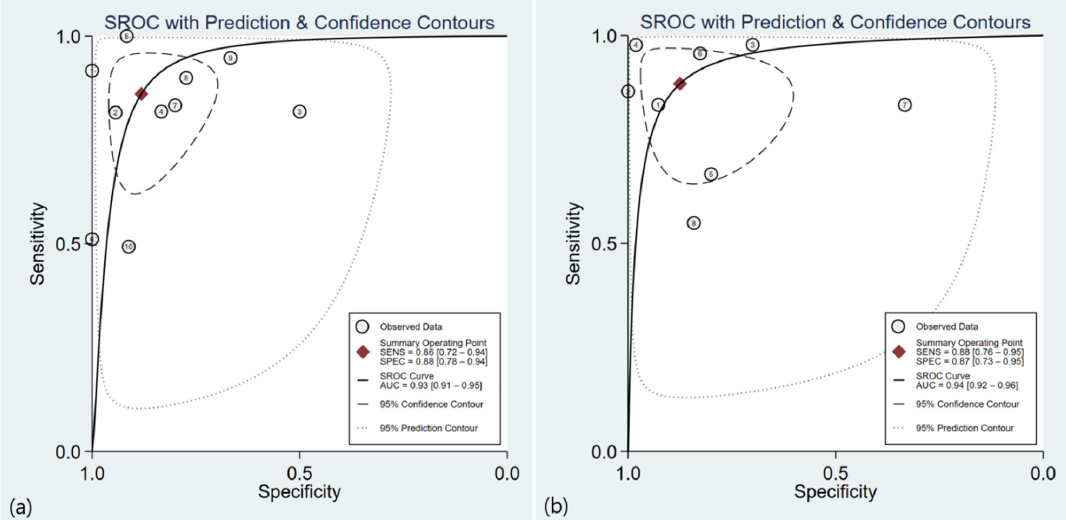
Figure 5. Hierarchical summary receiver operating characteristic (HSROC) curve of the diagnostic performance of ( a ) US and ( b ) MRE for diagnosing active bowel lesions in patients with Crohn’s disease. US, ultrasonography; MRE, magnetic resonance